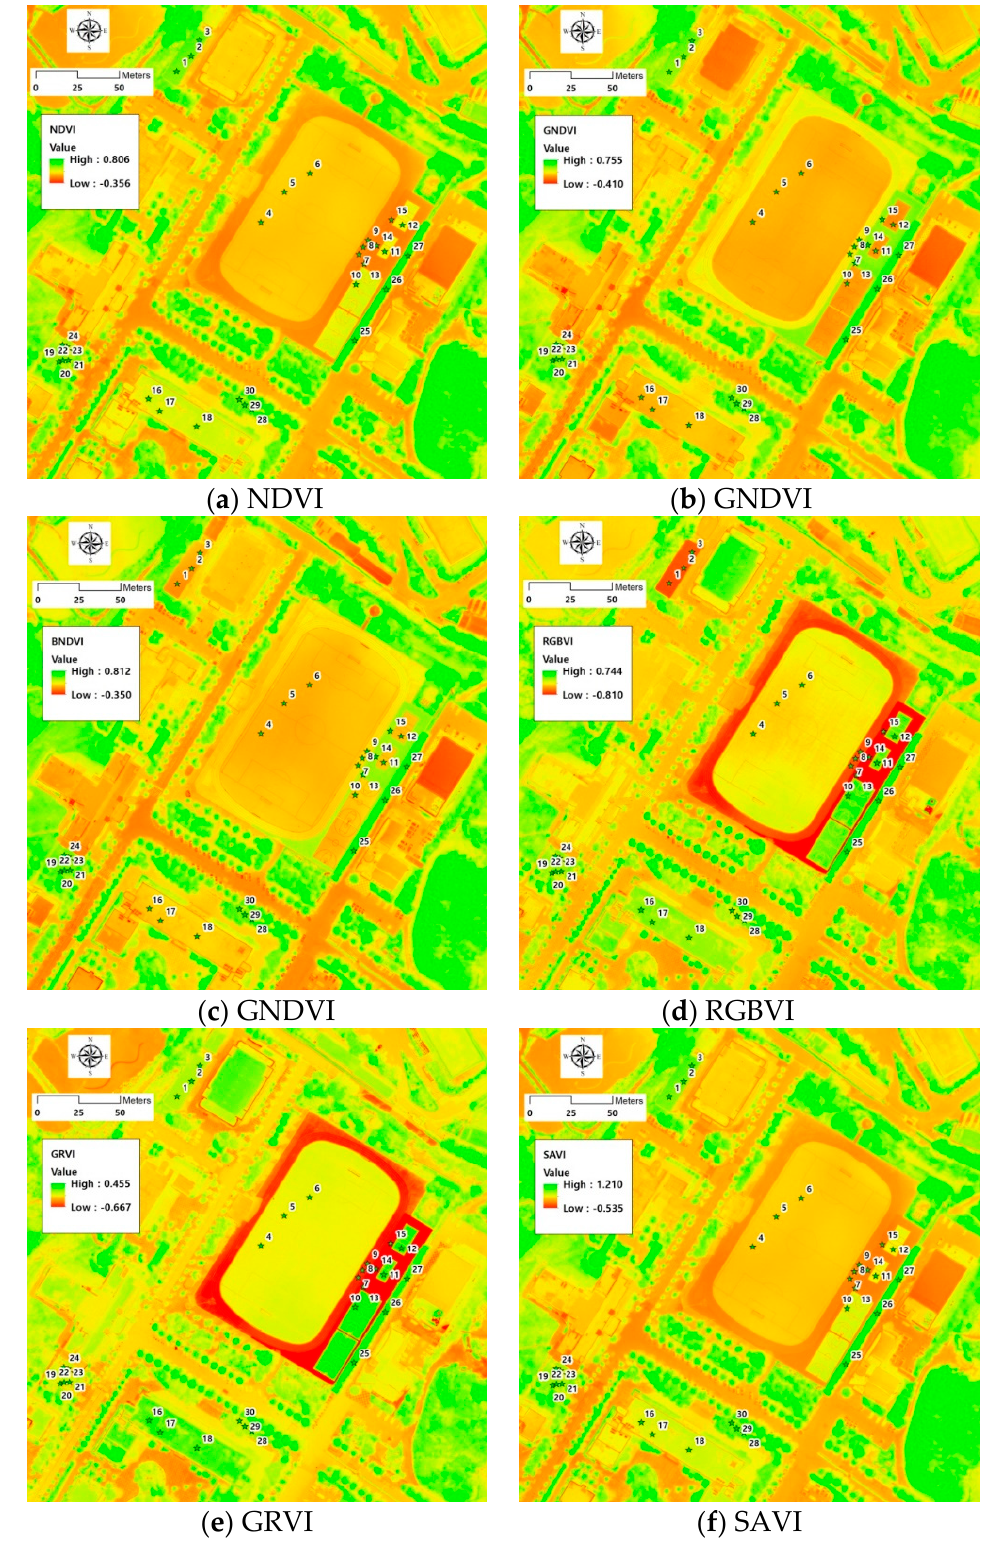
Figure 6. Maps produced using existing vegetation index equations.